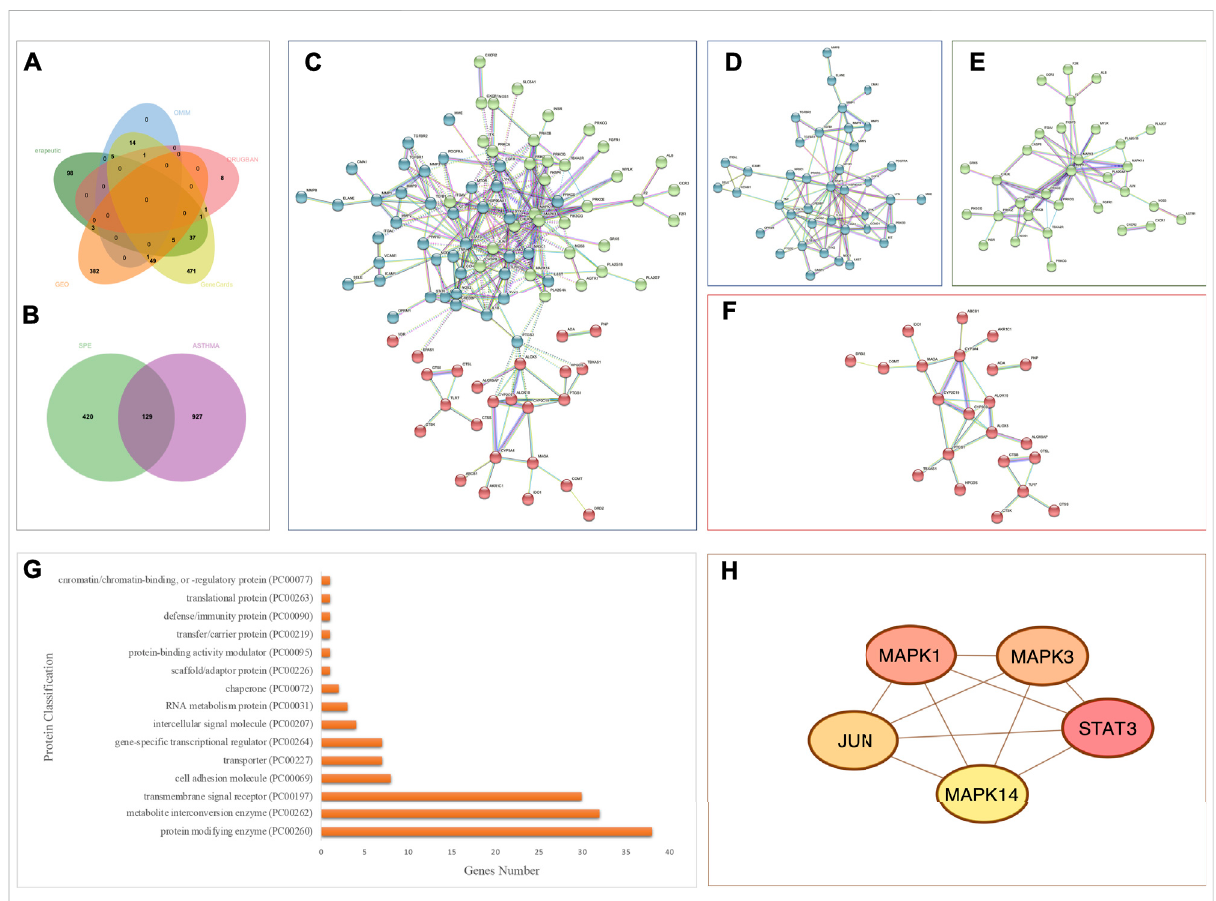
FIGURE 6 Analysis of asthma-related targets and overlapping targets between the PEF and asthma. (A) Venn diagram of asthma-related targets; (B) 129 overlapping targets. (C) Overall PPI analysis of 129 overlapping targets. (D) Cluster 1. (E) Cluster 2. (F) Cluster 3. (G) Protein classi fi cation by the Panther database. (H) Top fi ve genes by degree ranking in the PPI using the cytohubba